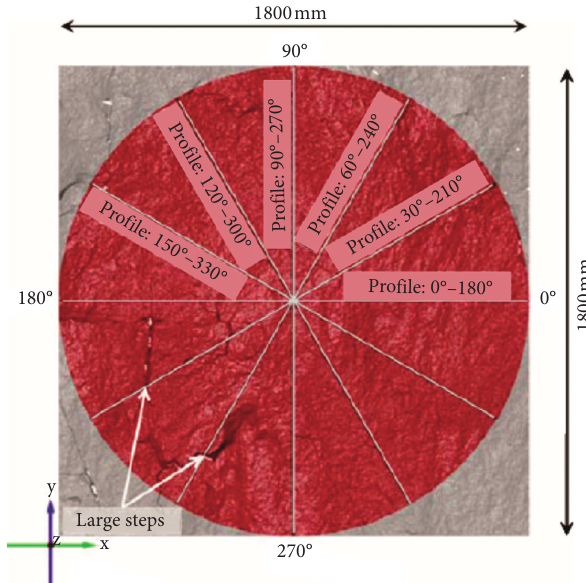
Figure 11: The location and orientation of the 2D profiles extracted from the square sampling window